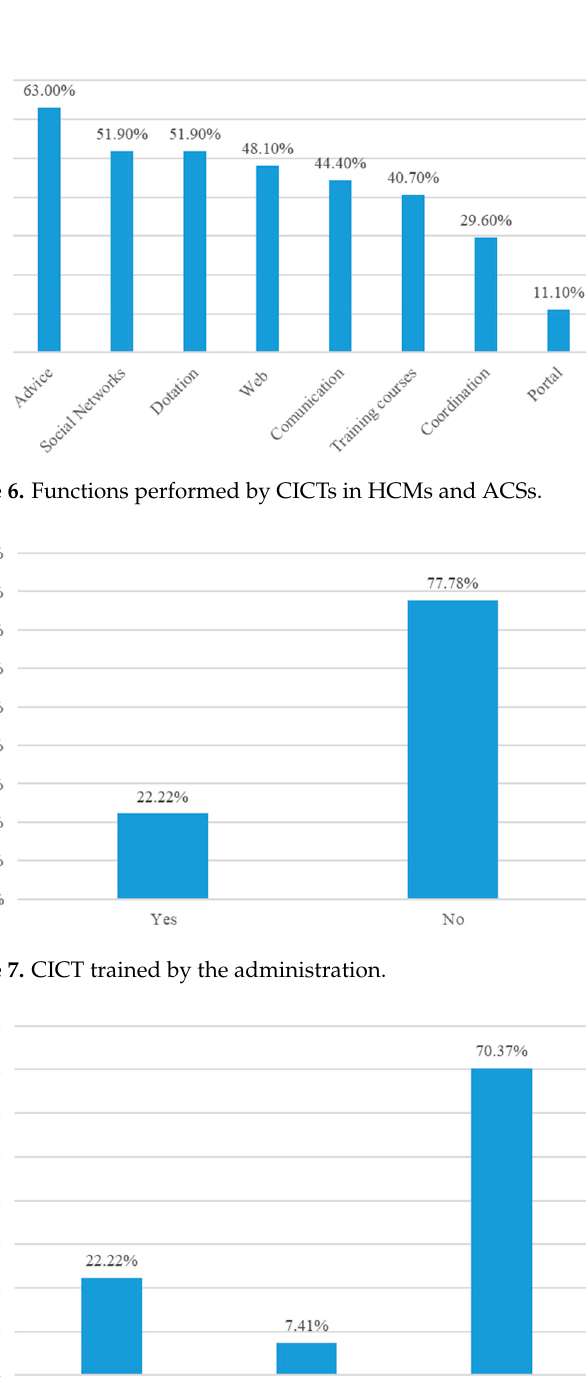
Figure 8. Assessment of the need for the existence of the CICT .